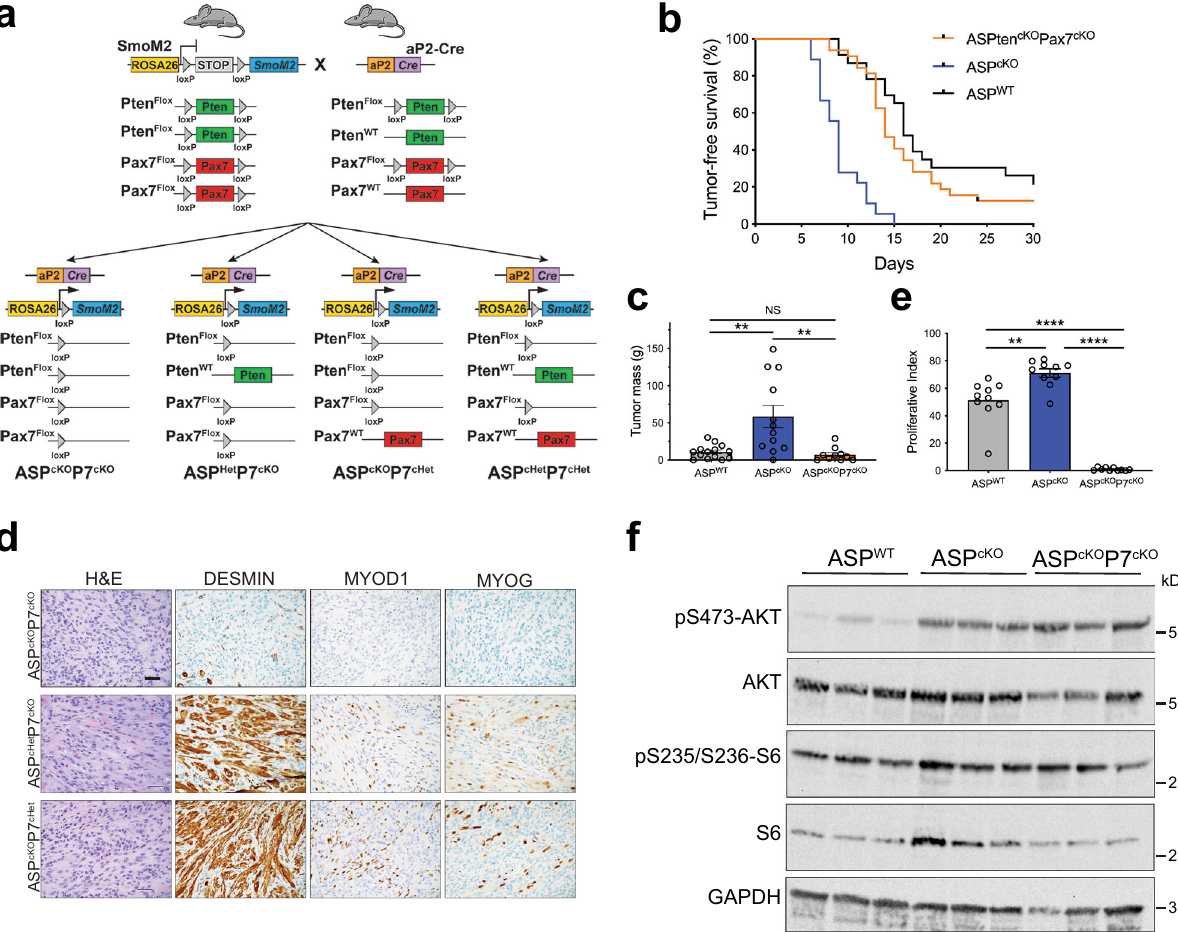
Fig. 7 PAX7 loss rescues deleterious effects of Pten loss in ASP cKO tumors. a Breeding strategy to generate ASP cKO P7 cKO tumor mice. b Kaplan – Meier tumor-free survival curve of ASP cKO P7 cKO ( n = 32) in comparison to ASP WT and ASP cKO mice (from Fig. 1b). Mantel – Cox log rank, P < 0.0001. c Tumor mass of ASP cKO P7 cKO ( n = 10), ASP WT ( n = 11) and ASP cKO ( n = 12) tumors at P12. ASP WT and ASP cKO data are the same from Fig. 1c. (ASP WT -ASP cKO P = 0.0022, ASP cKO -ASP cKO P7 cKO P = 0.0056). d Representative histology of ASP cKO P7 cKO ( n = 14), ASP cHet P7 cKO ( n = 4), and ASP cKO P7 cHet ( n = 4) tumors by H&E staining and IHC for DESMIN, MYOD1, and MYOG. Scale bar, 25 μ m. e Quantitation of percent Ki67-positive nuclei in ASP WT ( n = 9), ASP cKO tumors ( n = 7), and ASP cKO P7 cKO ( n = 5) tumors (ten random fi elds of view per genotype). ASP WT and ASP cKO from Fig. 1f. (ASP WT -ASP cKO P = 0.0029, ASP WT -ASP cKO P7 cKO P < 0.0001, ASP cKO -ASP cKO P7 cKO P < 0.0001). f Immunoblots of phosphorylated AKT Ser473 , AKT, phosphorylated S6 Ser235/236 , S6, and GAPDH, n = 3. All P values in pairwise comparisons were determined by Student ’ s t test (unpaired, two-tailed); NS not signi fi